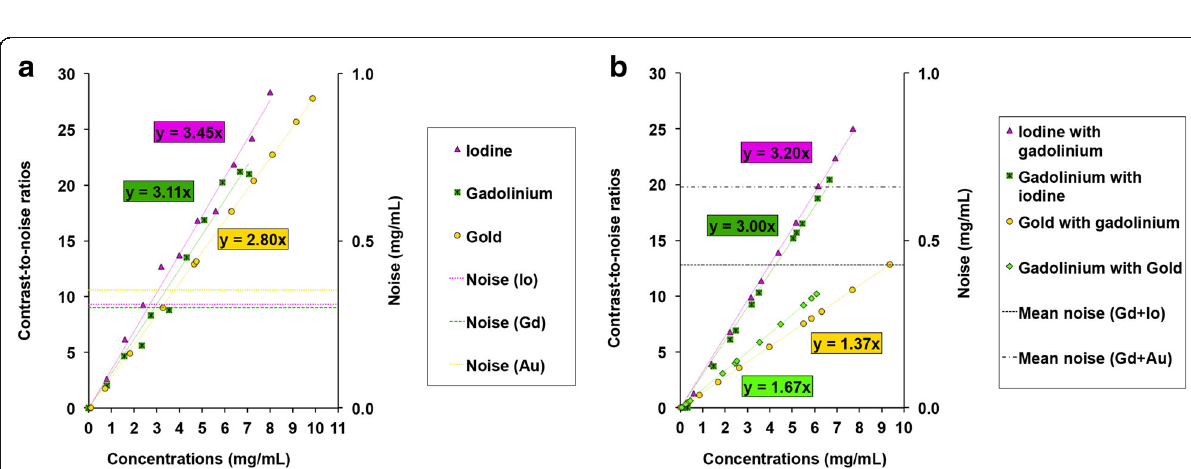
Fig. 6 CNRs of the contrast agents. The graphs represent the CNR values depending on the concentration of the contrast agent and the noise values of the contrast agents measured in their respective contrast material maps within the unmixed ( a ) and mixed ( b ) solutions. The dotted lines represent the noise measured in a tube filled with PBS only within the contrast material images. Mean noise is the mean of the noise measured within the two contrast material images of each mixture